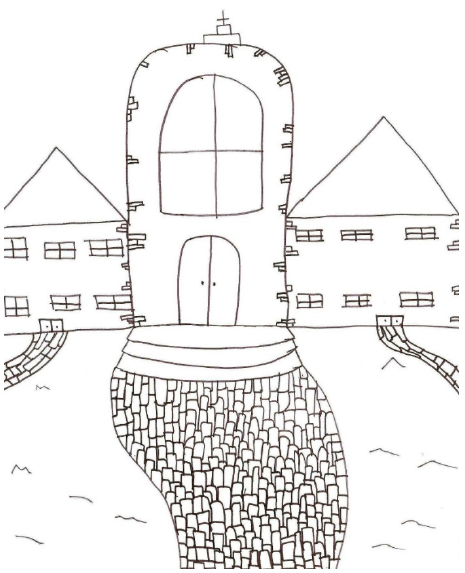
Figure 5. Expectation drawing showing entrance.